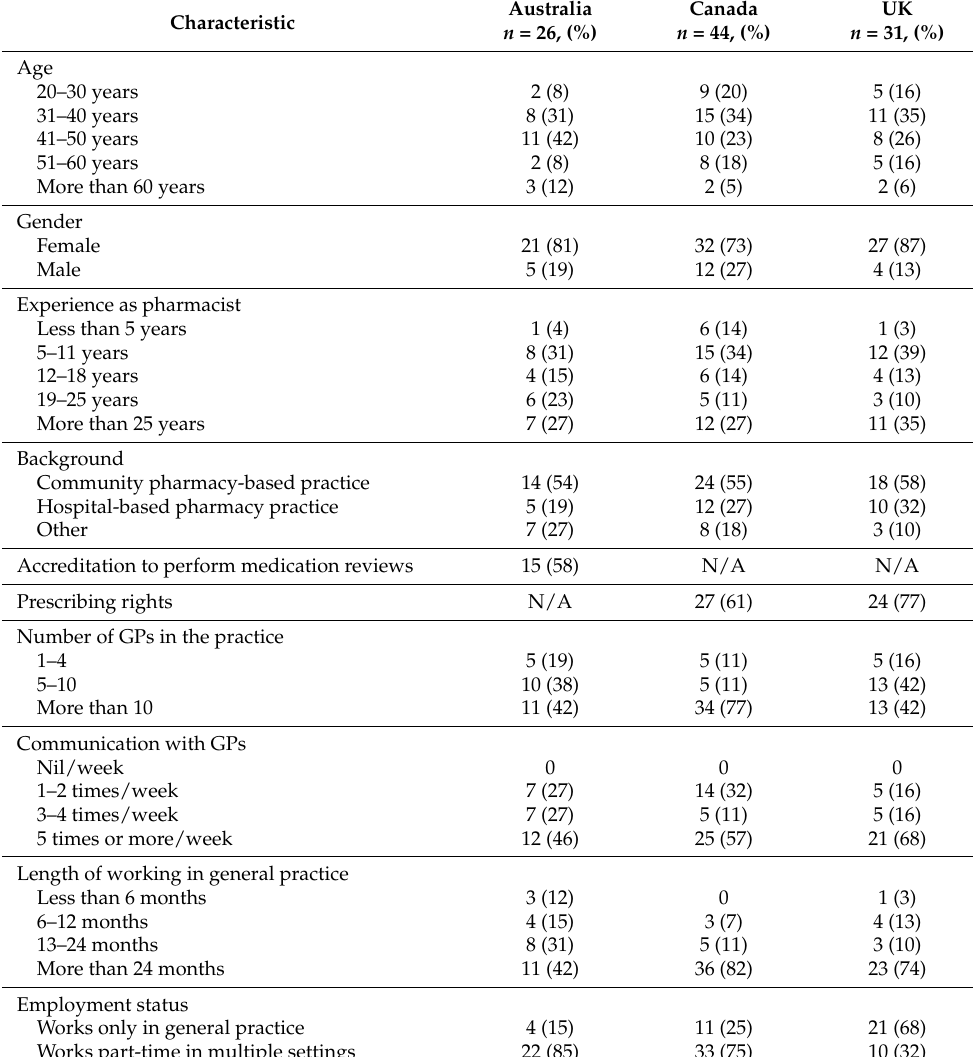
Table 1. Characteristics of